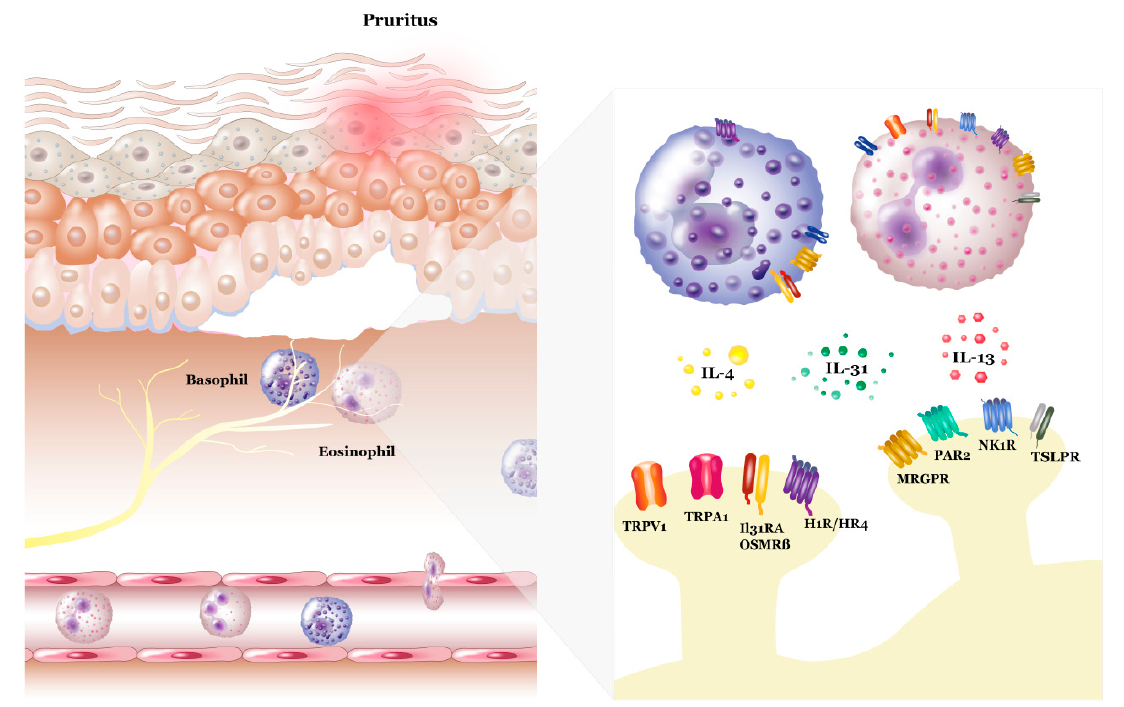
Figure 1. Neuro-immune interaction mechanism in pruritic skin diseases. Crosstalk between keratinocytes, immune cells, and sensory nerves is involved in the pathophysiology of pruritus. Immune cells (eosinophils and basophils) infiltrate the lesional skin from the peripheral blood and release inflammatory and pruritic mediators, such as IL-31, histamine, and BDNF. In addition, neurons modulate the function of immune cells by releasing neurotransmitters and neuropeptides. Several receptors and channels (IL-31 receptor A (IL-31RA), as well as the oncostatin m receptor (OSMR), transient receptor potential vanilloid 1 (TRPV1) and ankyrin 1 (TRPA1), thymic stromal lymphopoietin